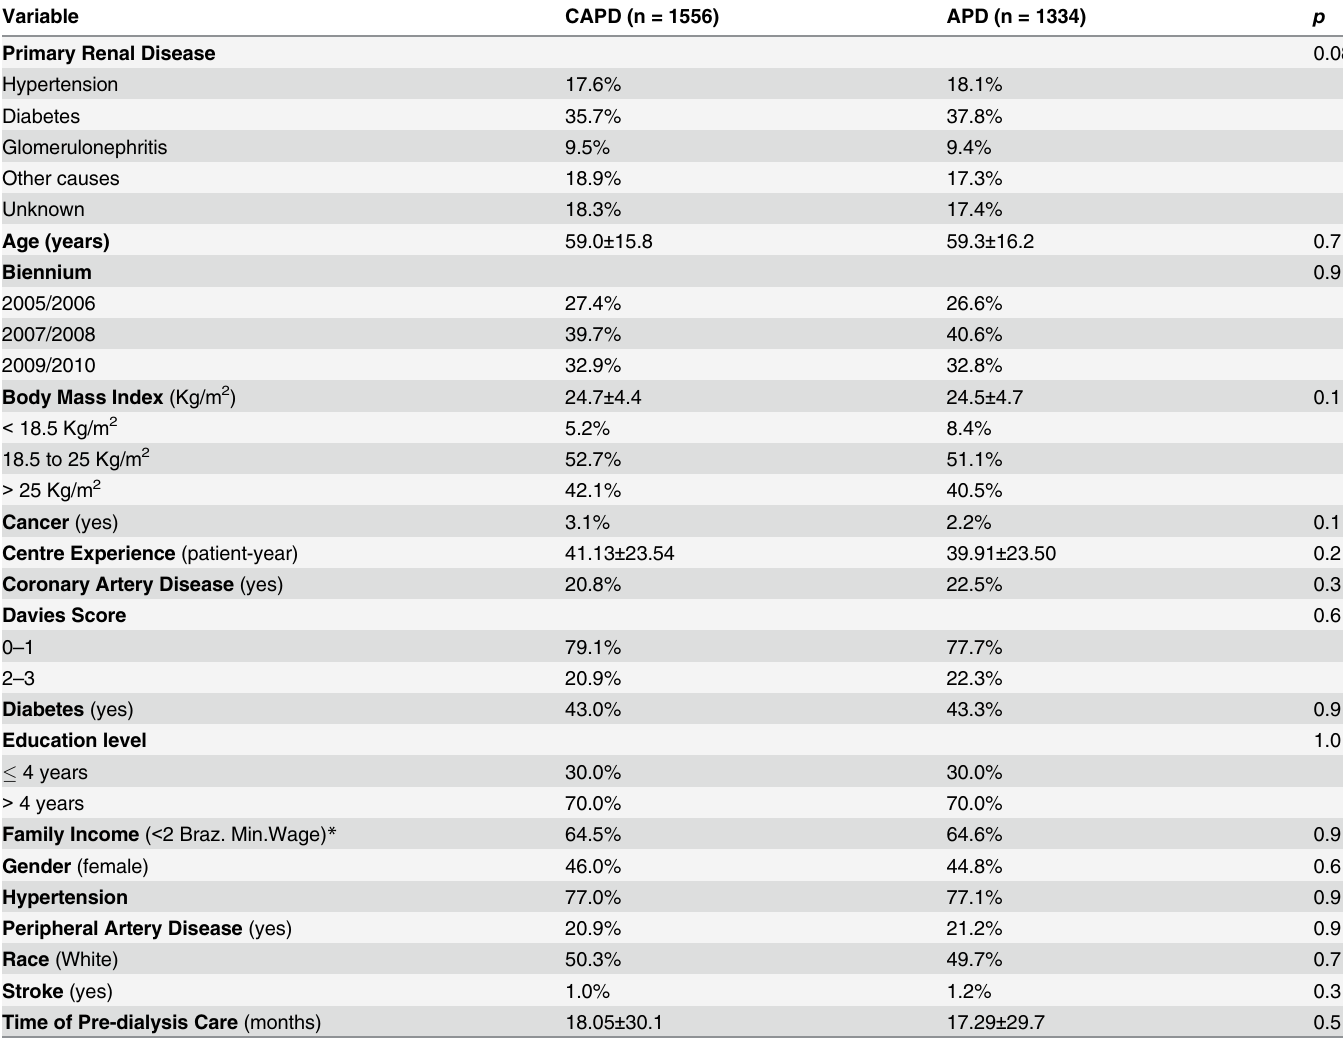
Table 1. Clinical and demographic characteristics of matched